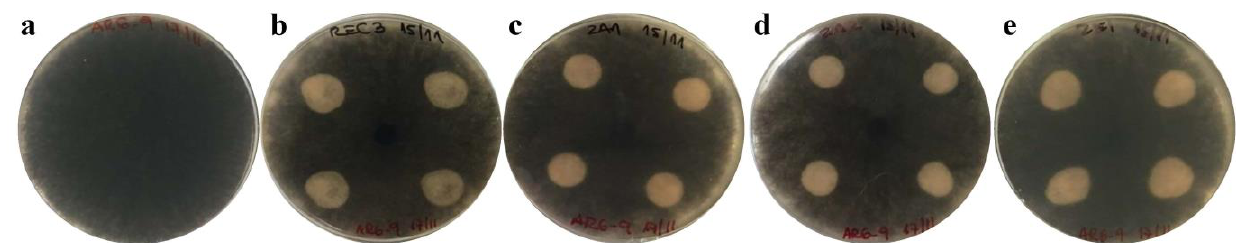
Figure 1. In vitro antagonism results of A. brasilense REC3 ( b ), 2A1 ( c ), 2A2 ( d ), and 2E1 ( e ) strains vs. M. phaseolina isolate Fru-SWA, after 4 d incubation. The control plate was only inoculated with the M. phaseolina isolate Fru-SWA ( a ).